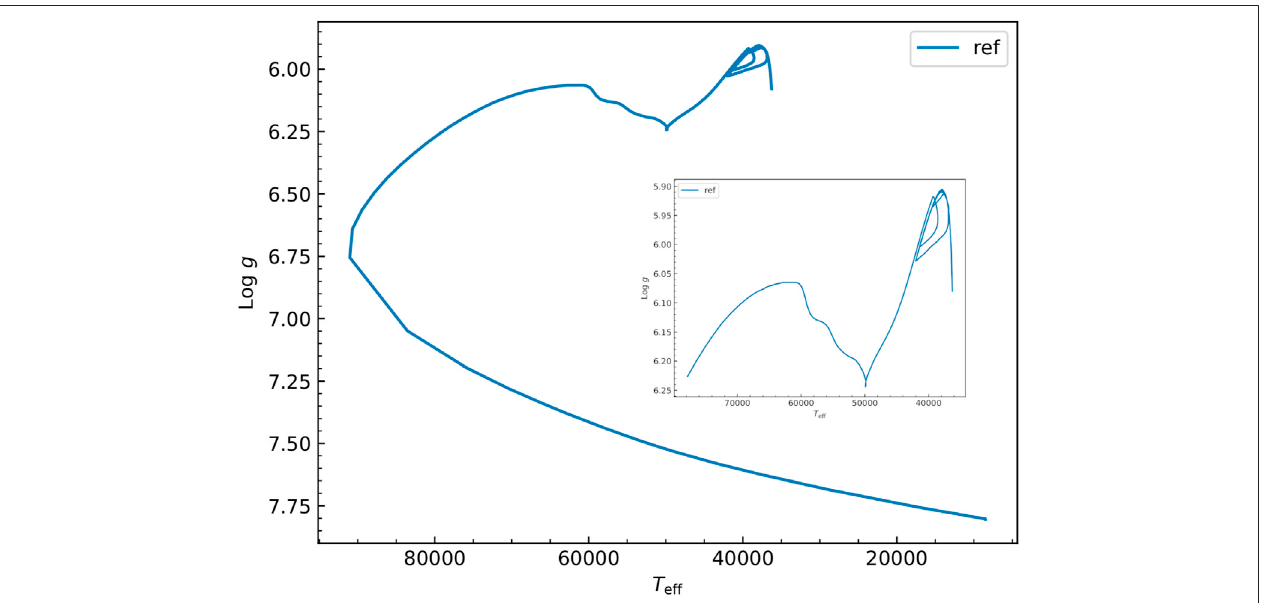
FIGURE 12 | log g − T eff diagram showing a representative evolutionary track computed with STELUM for a typical, M tot = 0.48 M ⊙ , EHB star having a thin hydrogen-rich envelope of logarithmic mass fraction log q ( H ) ≡ log( M env / M tot ) = − 5.0. The sequence starts at helium ignition (ZAEHB; upper right end of the curve) and proceeds through core helium burning (until the dip near 50,000 K), helium shell burning, and ultimately the white dwarf cooling stage down to T eff ~ 8500 K. The insert shows a closer view of the track during the helium-core and helium-shell burning phases.